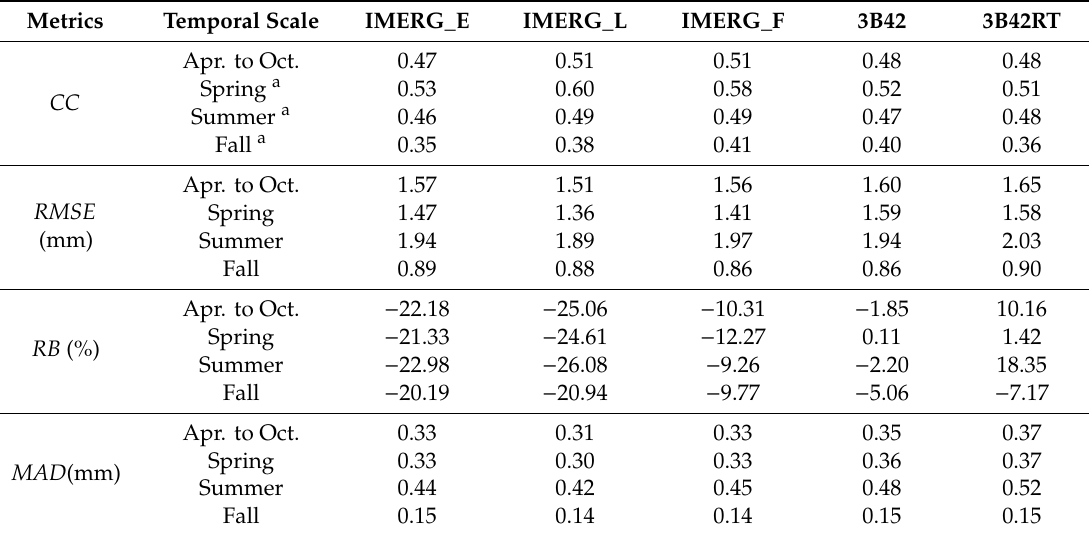
Table 6. Mean continuous evaluation metrics of the SPPs at hourly